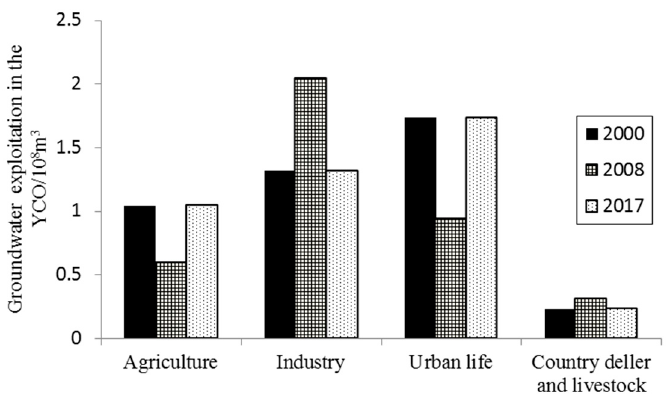
Figure 7. Groundwater exploitation of different industries in the YCO during 2000–2017.